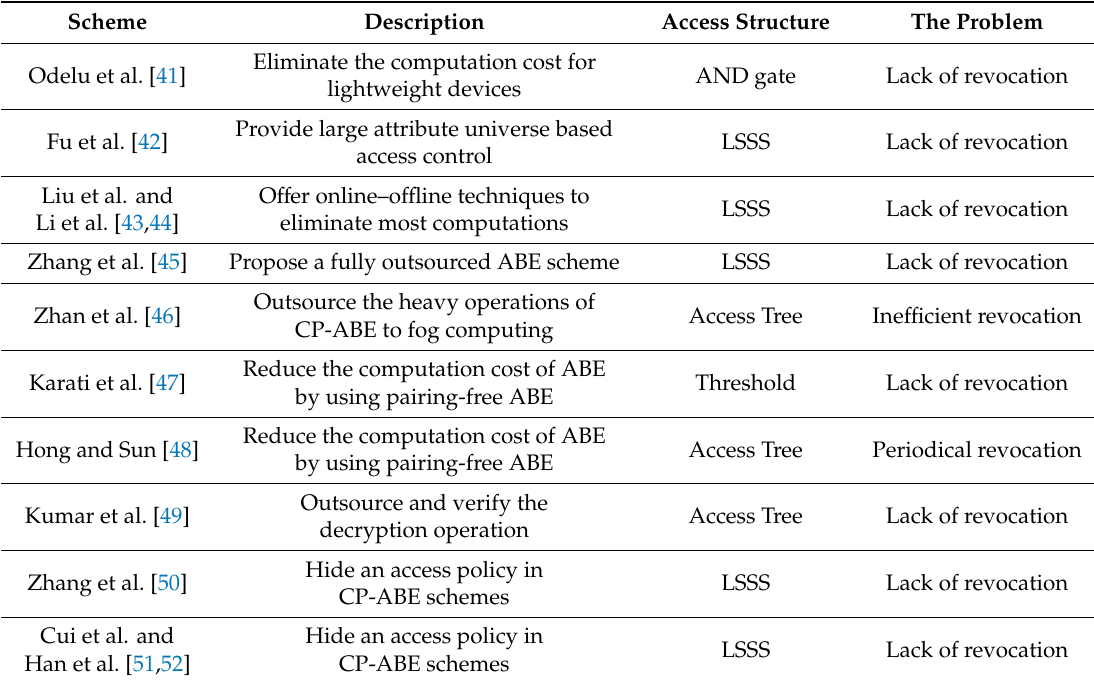
Table 3. Summary of main existing systems and their